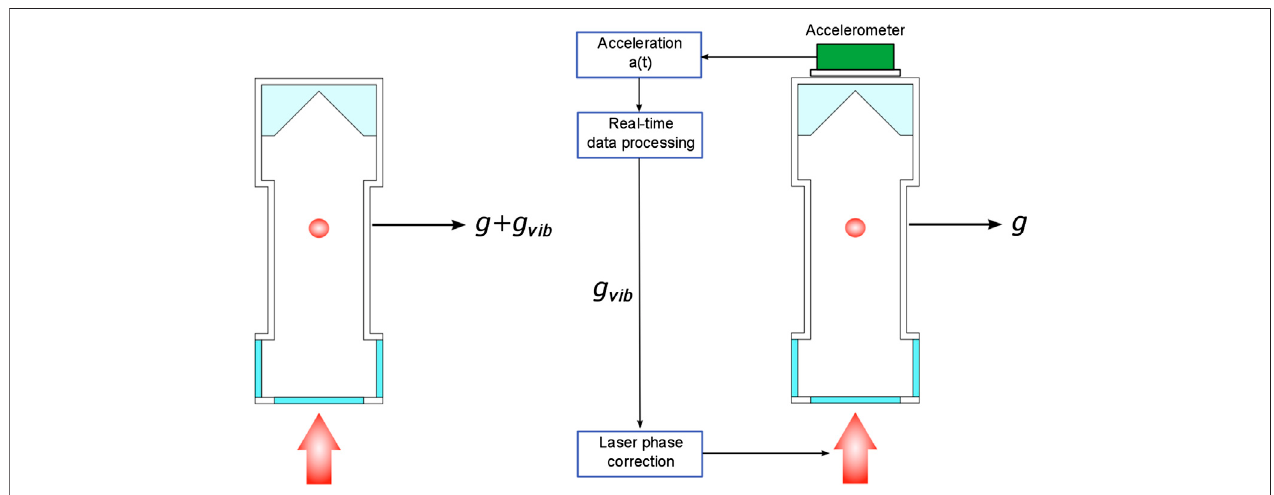
FIGURE 8 | Real-time compensation of ground-vibrations on the absolute quantum gravimeter. Left: without classical accelerometer, ground vibrations would directlyaffectthegravitymeasurement. Right: Aclassicalaccelerometerisattachedtothetopofthesensorhead.Itssignalisprocessedinreal-timeinordertoprovidea feedback on the lasers, and remove vibrations from the gravity